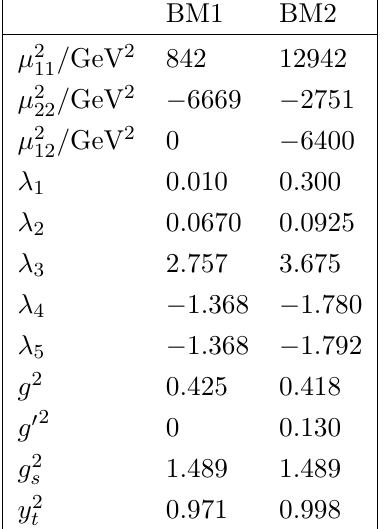
Table 2. Renormalized parameters corresponding to the input parameters in table 1. The recipe for obtaining these is described in the main text and in appendix A. In BM1, we have set the U(1) coupling to zero for the sake of comparison with the results of ref. [45]. The SU(3) coupling g s is (cid:12)xed at tree